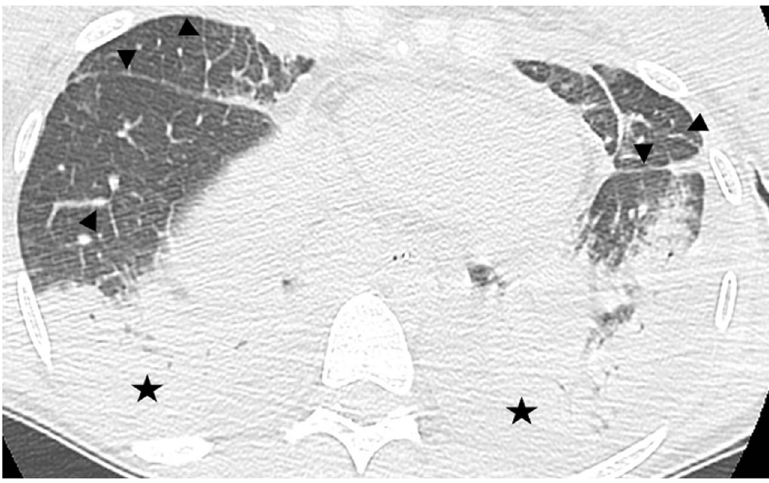
Fig. 2 Primary graft